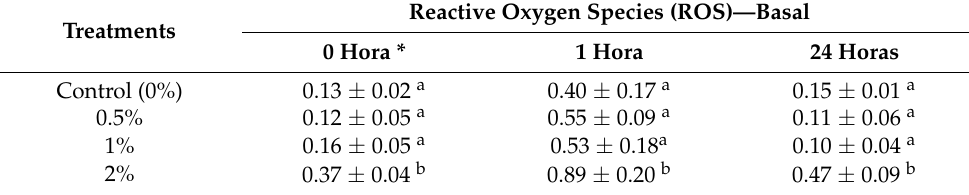
Table 6. Reactive oxygen species results of Litopenaeus vannamei fed for 15 days with diets containing 0, 0.5, 1 and 2% of Nannochloropsis